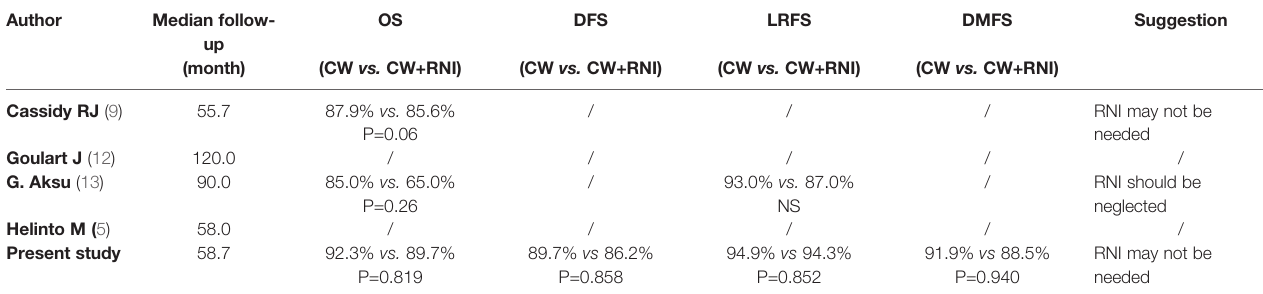
TABLE 6 | Survival radiotherapy to chest wall with or without regional lymph node in previous three reports and the present